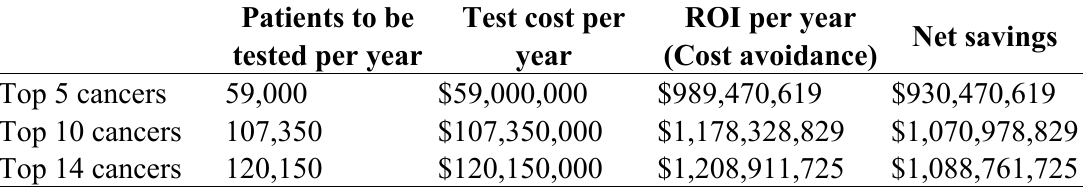
Table 3. Future ROI after test optimization example, in Canadian